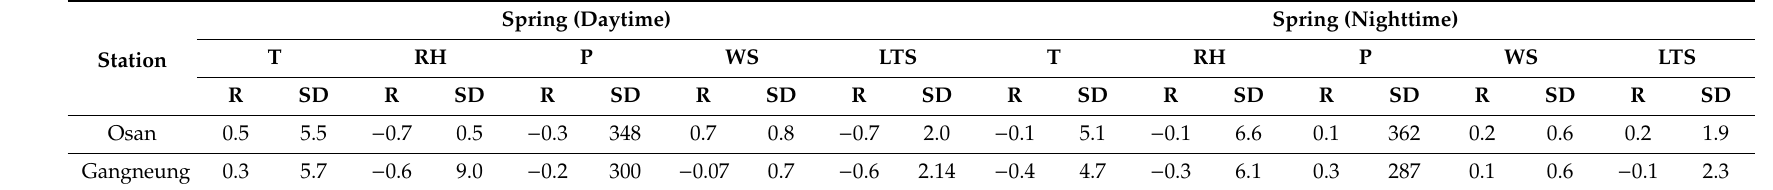
Table 2. Correlations between PBLH and meteorological parameters during spring.